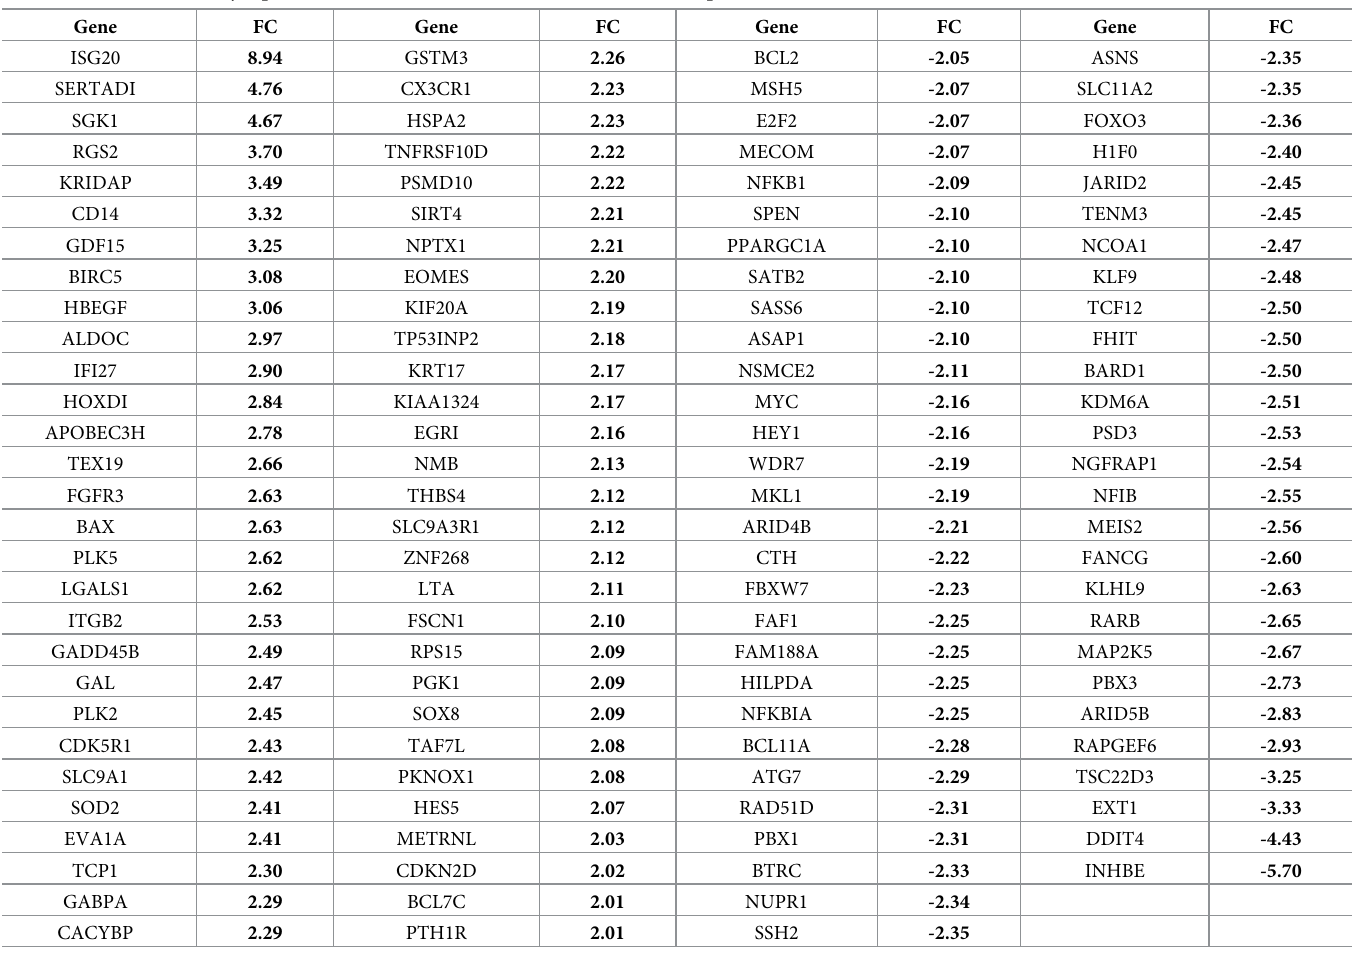
Table 2. Genes differentially expressed in HPV16 E1 transfected cells involved in cell proliferation and cell death.